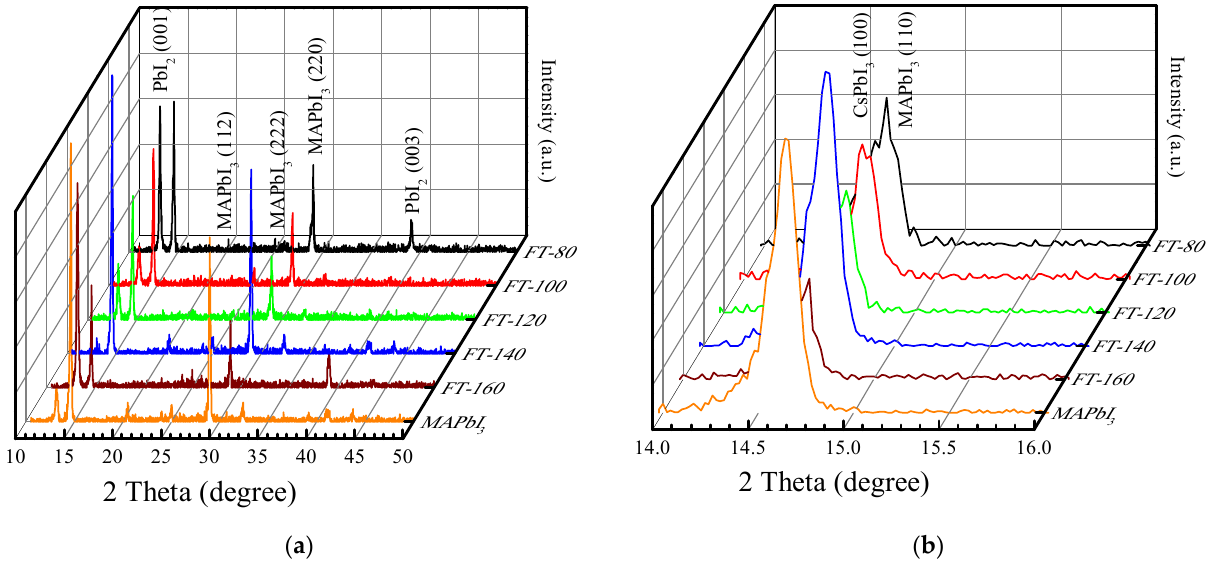
Figure 2. ( a ) XRD patterns of CsPbI 3 -QD doped perovskite thin films under 80–160 °C. ( b ) XRD patterns under the scale of 14°~16°.